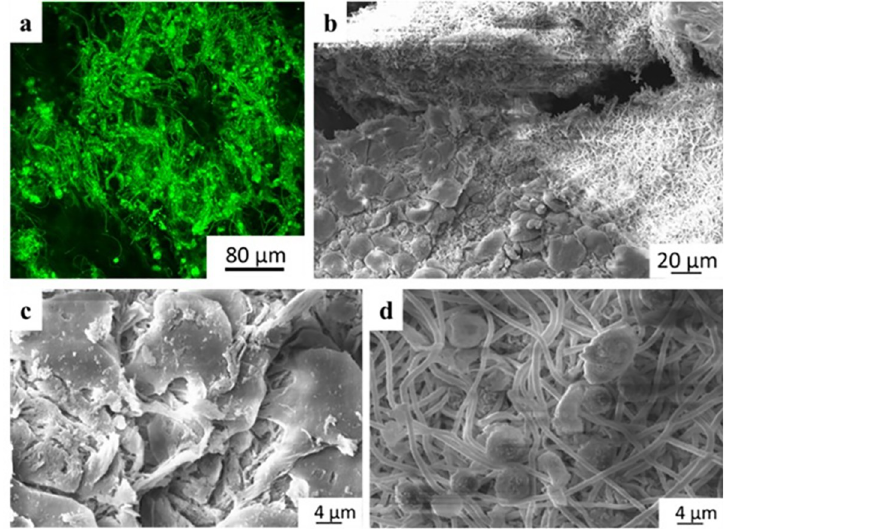
Fig 8. Multiphoton (a) and SEM (b, c, d) micrographs of PSIDAB sample from day